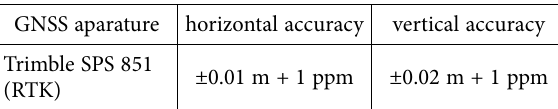
Table 1. Accuracy GNSS apparatus featured manufacturers